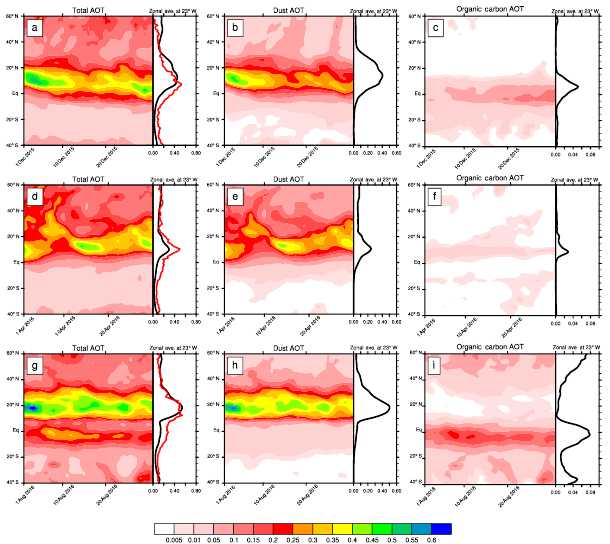
Figure 2. Latitude–time Hovmöller plot of NGACv2 total, dust and OC AOT (all at 550nm) over the Atlantic Ocean, zonally averaged (between 60 ◦ W and 30 ◦ E). Top row (a, b, c) is for December 2015, middle row (d, e, f) for April 2016 and bottom row (g, h, i) for July 2016. Line plots show zonal average of total, dust and OC AOT at 23 ◦ W (over Atlantic Ocean). NGACv2 and MODIS total AOT are represented by black and red lines, respectively, in the line plots.